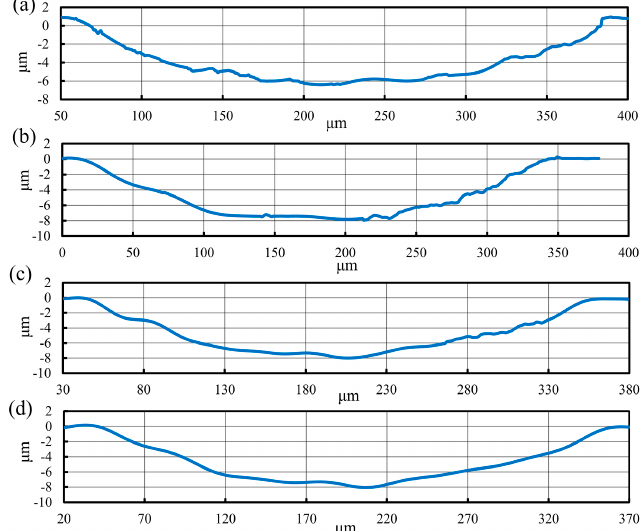
Figure 6. The cutting profiles of machined micro-groove (the predetermined depth of cut was 8 μ m): ( a ) processed by CC, ( b ) processed by UEVC (TSR = 1/12), ( c ) processed by UEVC (TSR = 1/24) and ( d ) processed by UEVC (TSR = 1/48). Table 3. The designed parameters and experimental results of the machined micro-grooves. Results of Results of Results of Test Parameters of the Designed Results of CC UEVC UEVC UEVC No. Micro-Groove Values Process Process Process Process (TSR = 1 / 12) (TSR = 1 / 24) (TSR = 1 /